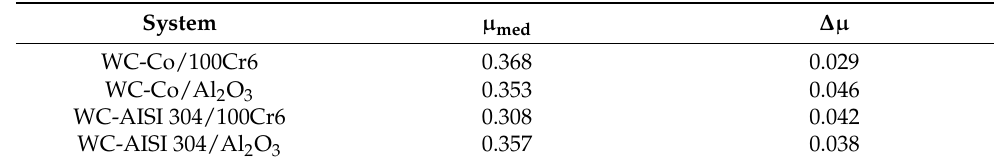
Table 6. Variation of coefficients of friction for the systems: WC-Co/100Cr6, WC-Co/Al 2 O 3 , WC-AISI 304/100Cr6 and WC-AISI 304/Al 2 O 3 .